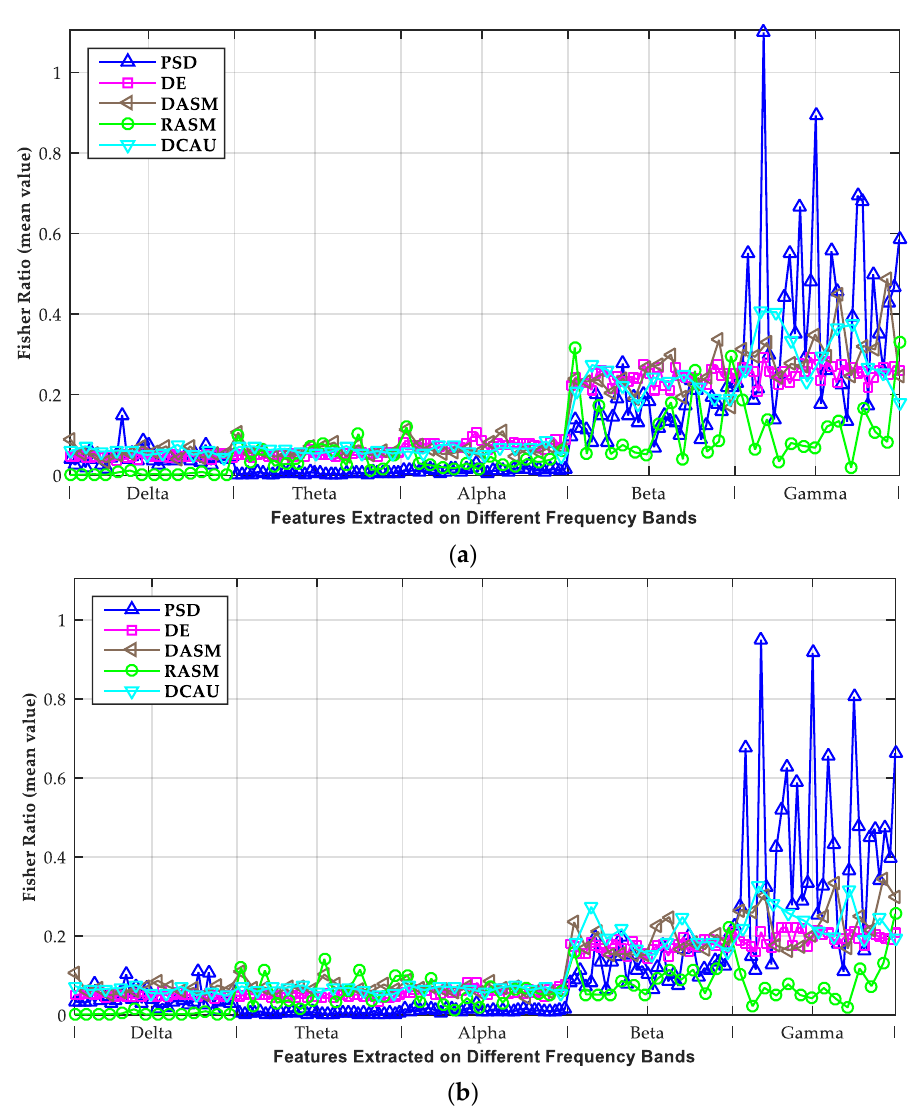
Figure 6. Fisher ratio of features extracted on different frequency bands by averaging the values over all subjects in (a) valence and (b) arousal dimensions, respectively. Table 4. Fisher ratio of different frequency bands by averaging the values over all features and subjects in valence and arousal dimensions, respectively.